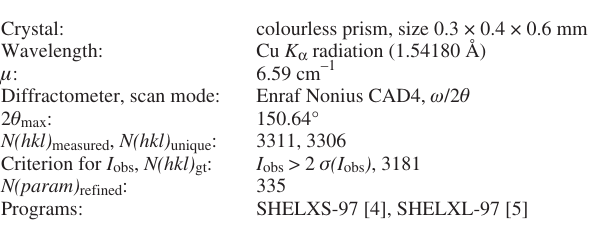
Table 1. Data collection and handling.